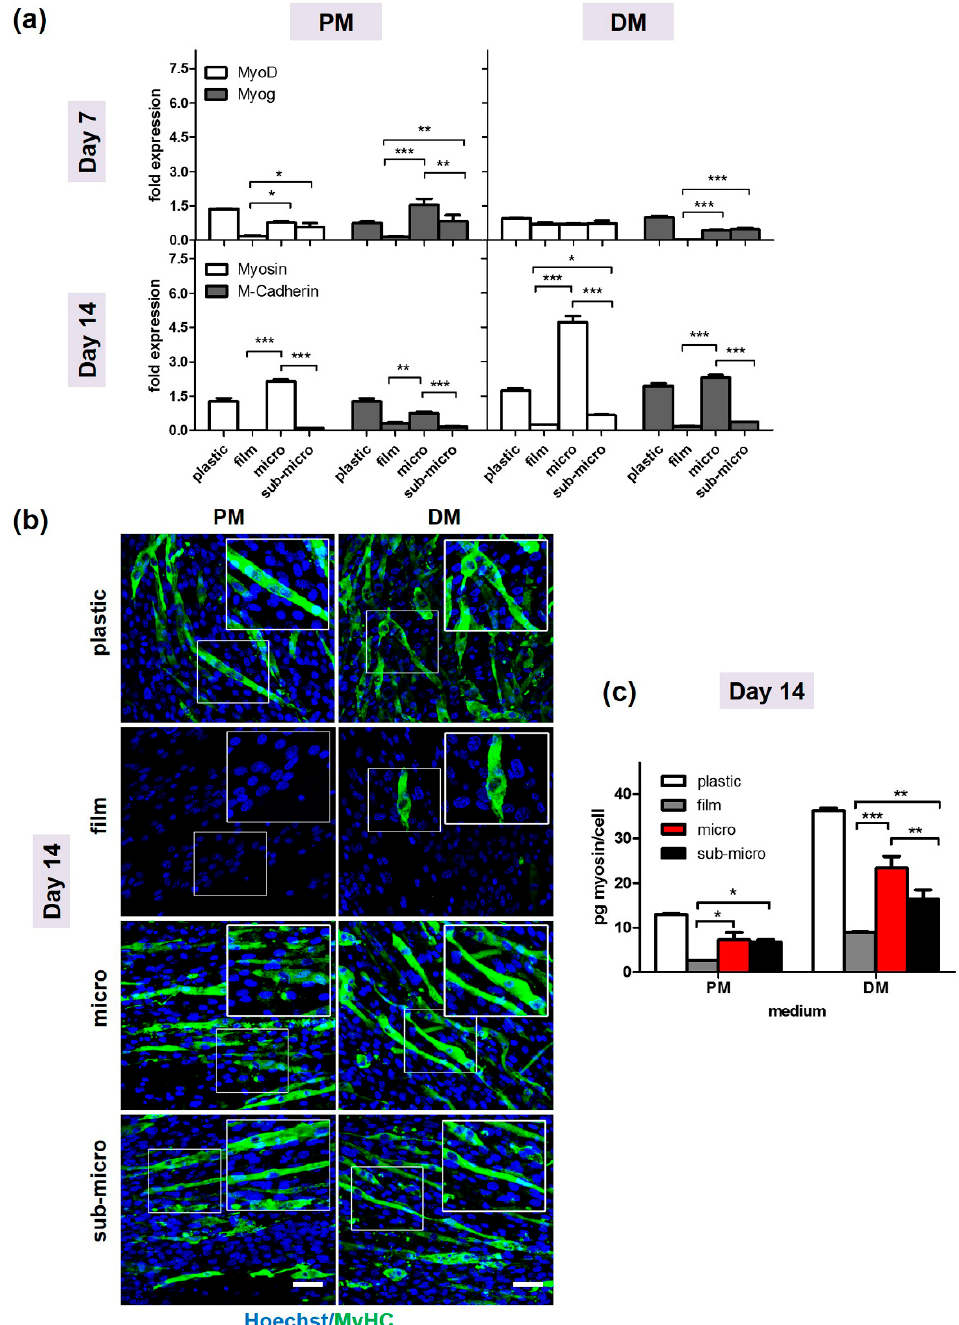
Figure 4. Differentiation of C2C12 cells on electrospun P73 scaffolds.C2C12 cells were seeded on film, micro-, and sub-micro-P73 scaffolds and cultured in proliferative medium (PM) or differentiation medium (DM) for 7 and 14 days, respectively. ( a ) By qRT-PCR, MyoD, and Myog gene expression levels were analysed at day 7 whereas MyHC and M-cadherin at day 14 in PM or DM. Values were normalised against phosphoglycerate kinase (PGK) expression. ( b ) Immunofluorescence images of cells cultured for day 14 in PM and DM. MyHC is stained in green (Alexa Fluor 488) and nuclei are stained in blue (Hoechst 33342). Magnified areas of myotubes in insets. Scale bars: 50 µm. ( c ) MyHC protein quantification by ELISA assay at day 14 in PM or DM; * p < 0.05; ** p < 0.01; *** p < 0.001. Plastic = standard tissue culture plates; PM = Proliferation Medium; DM = Differentiation Medium.